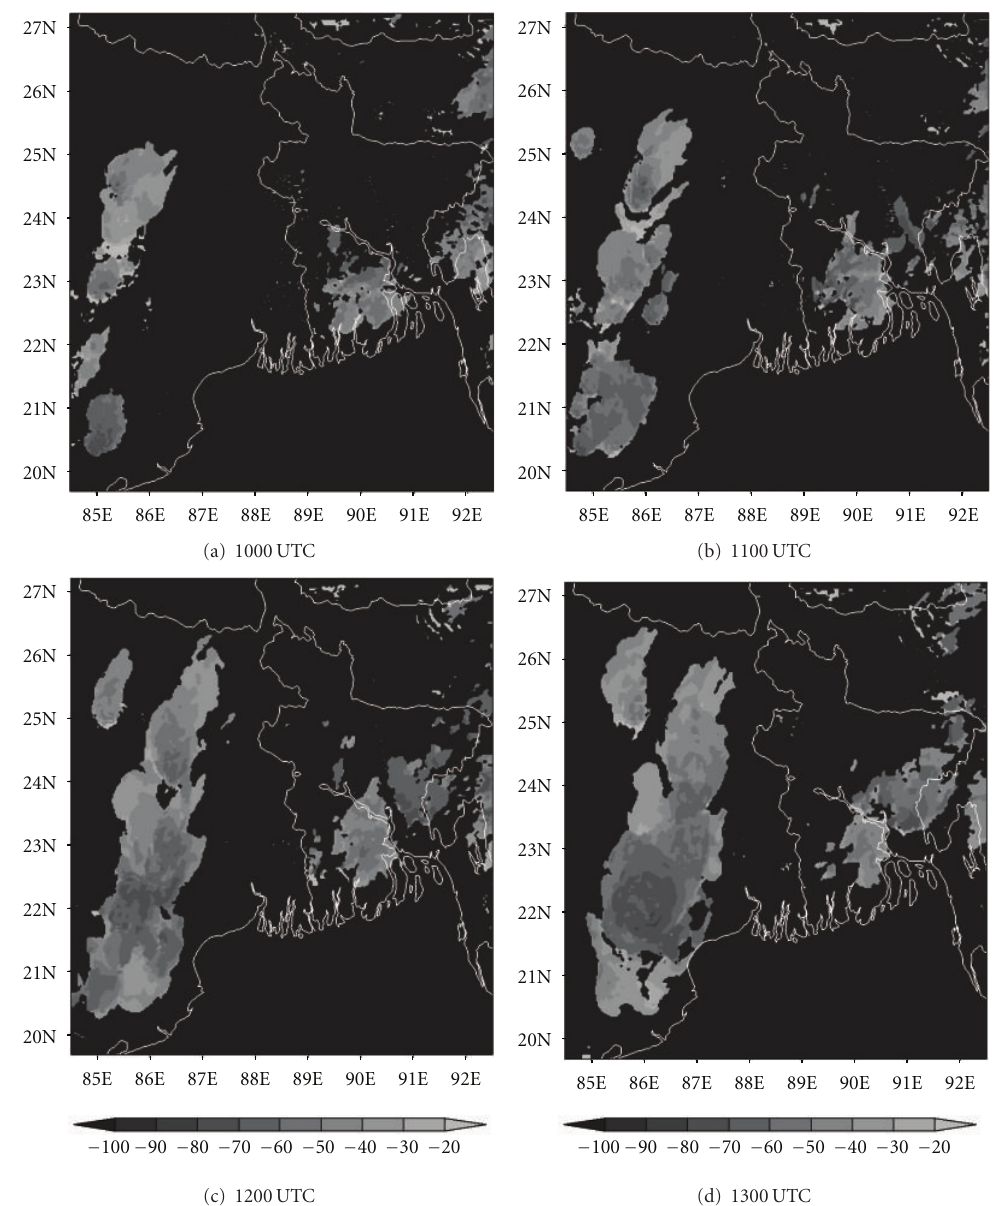
Figure 15: ARW-model-simulated cloud top temperature ( ◦ C) from 1000 to 1300 UTC on 03, May,